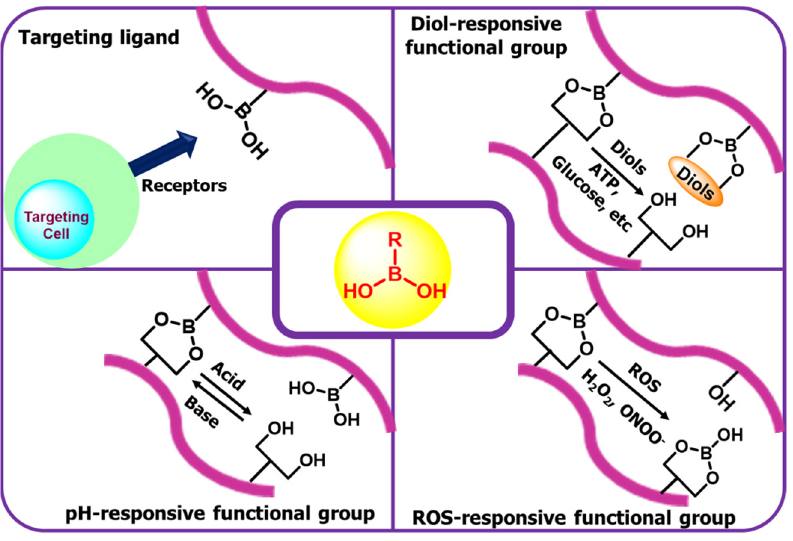
Figure 5. Schematic representation of stimuli-responsive boronic acid-based release.